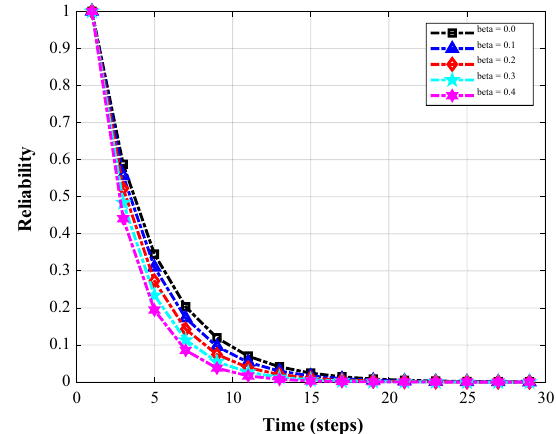
Fig. 14 Reliability performance at low system diagnostic coverage level and 95% repair